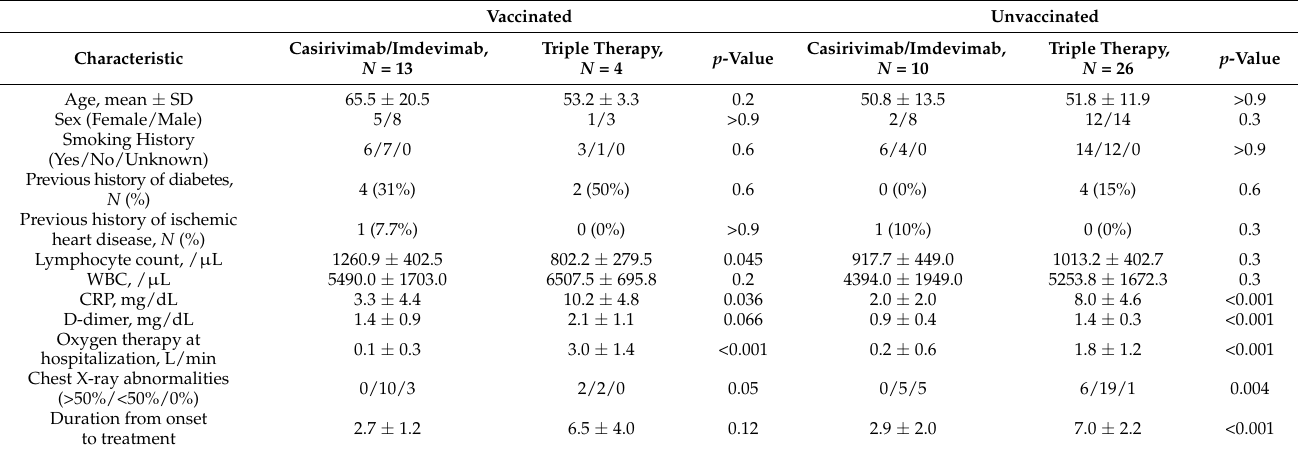
Table 1. Patient characteristics during the delta